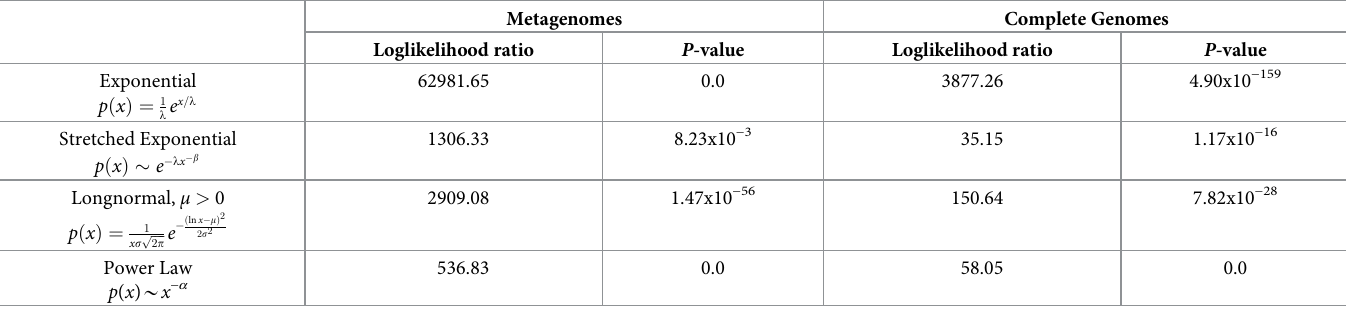
Table 2. Comparison of the truncated power law p ( x ) * x − α e − λ x to other heavy-tailed candidate distributions in fitting empirical distribution of spacers. Positive Loglikelihood ratios indicate that the Truncated Power Law fits the empirical data better than the candidate distribution